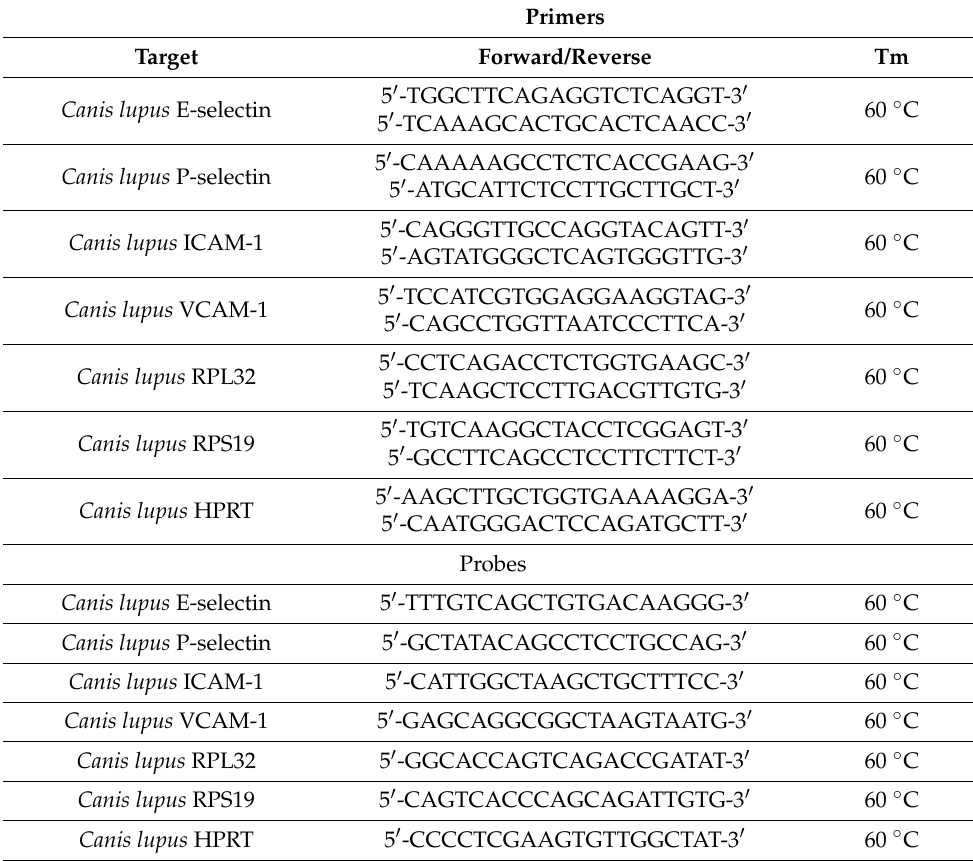
Table 1. Sequences of canine probes and primers used for qRT-PCR